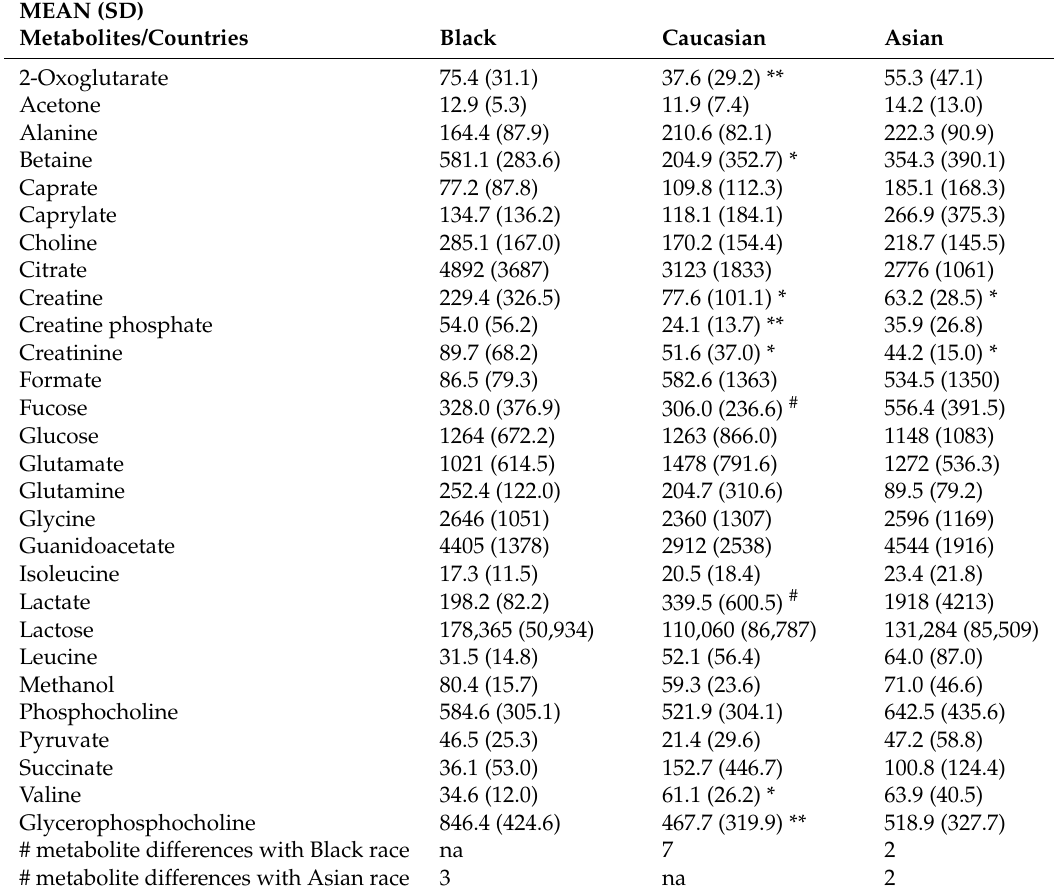
Table 2. Comparison of milk metabolite concentrations ( µ mol/L) by maternal